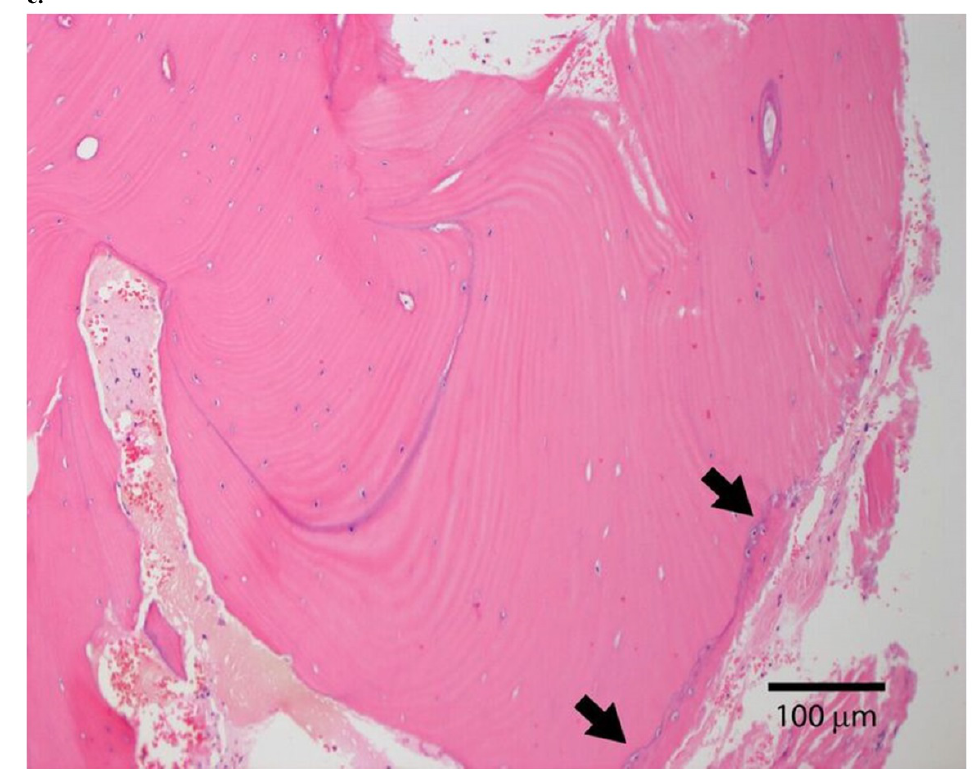
Figure 11. a. Synovium: At scanning magnification, the synovium showed slight villous hyperplasia and scant exudate (20X original magnification). b. Synovium: A moderately dense acute inflammatory infiltrate was present in the subsynovial connective tissue (200X original magnification). c. Bone: The bone was viable without significant inflammation or scalloping and thus there was no definite histologic support for acute osteomyelitis. A small focus of new, woven bone (arrows) was noted in the subperiosteal compartment, which, while nonspecific, suggested reaction to a soft tissue process (100X original magnification).